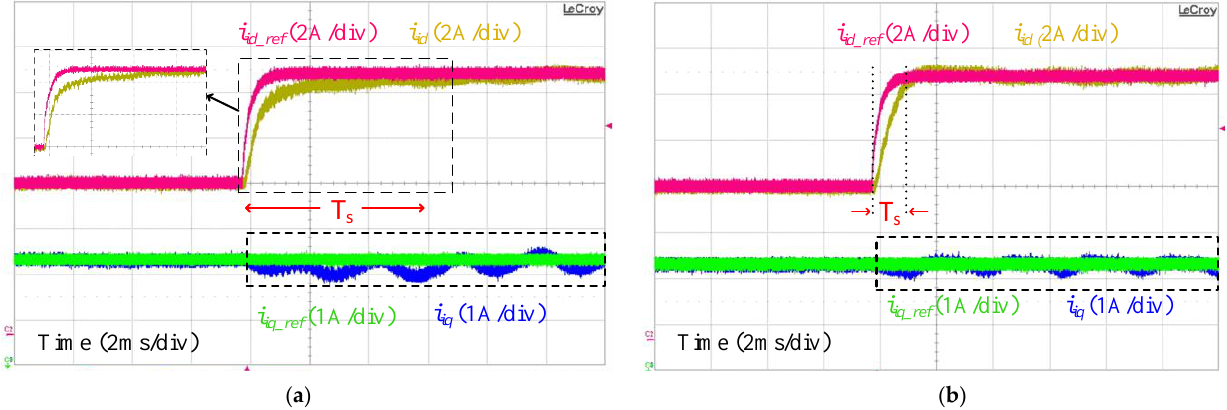
Figure 21. Current tracking of i id and i iq with L grid = 0 ( a ) single-loop PI control; ( b ) RESO-based ADRC.